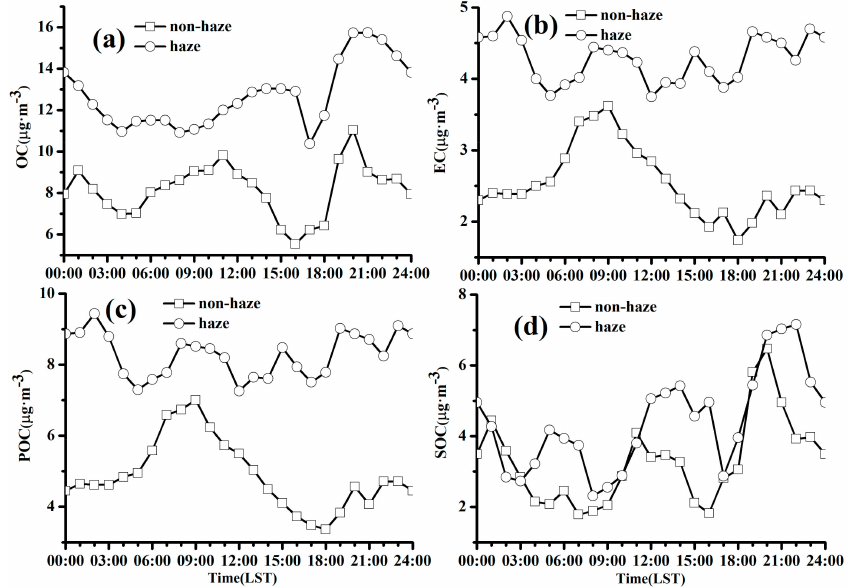
Figure 8. Diurnal variation of OC ( a ), EC ( b ), POC ( c ) and SOC ( d